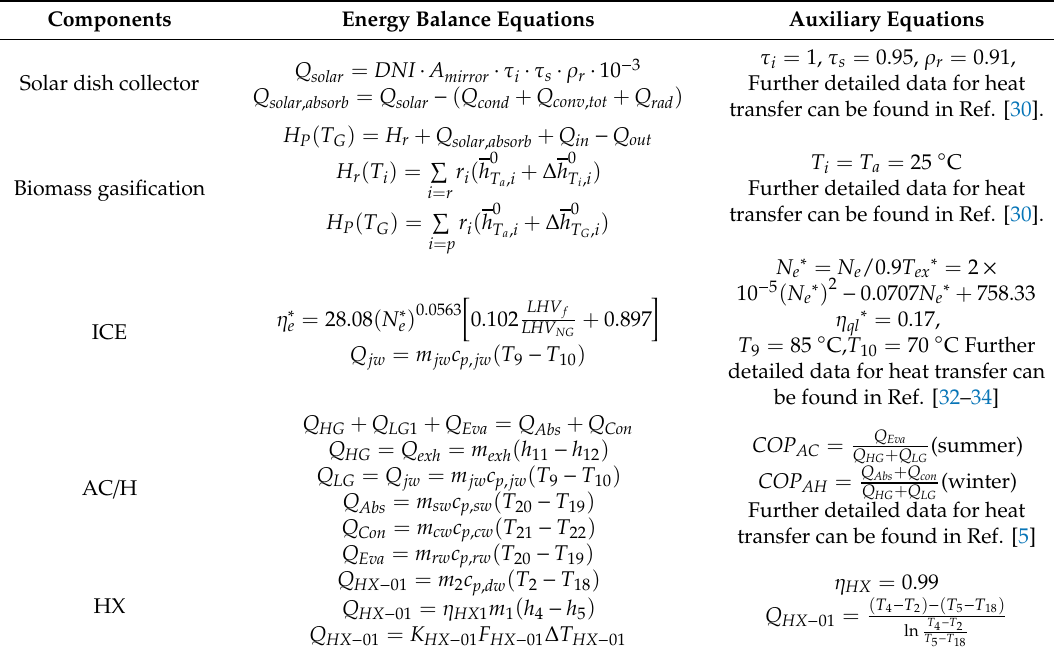
Table2. EnergyprinciplesoftheCCHPsystem(ThedefinitionsofsymbolsaregivenintheNomenclature